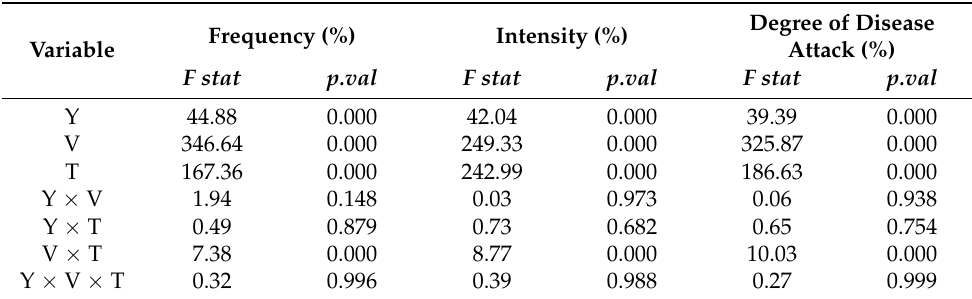
Table 7. Correlations between the tested rust disease control products and three raspberry varieties for a two-year period of investigation. ANOVA test for differences ( p < 0.001).